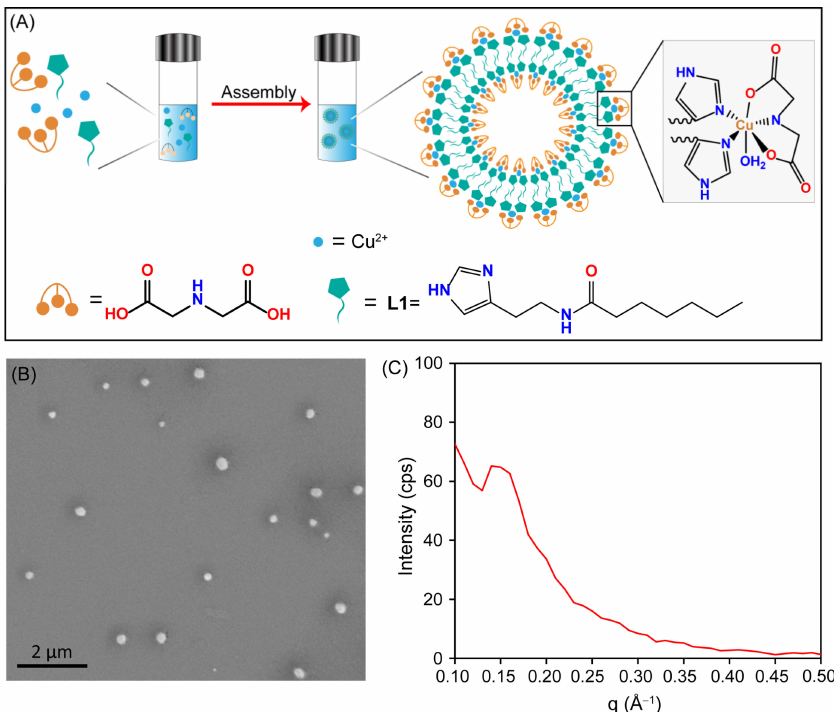
Figure 1. Fabrication of SupraZyme and its characterizations. ( A ) A schematic of assembly formation with Cu(NO 3 ) 2 , IDA, and ligand L1 . ( B ) SEM image of the SupraZyme showing vesicular structures, ( C ) SAXS spectrum of the SupraZyme showing a peak corresponding to the q value of 0.15 Å − 1 . Experimental conditions: [Cu 2+ ] = 100 µ M, [ L1 ] = 200 µ M, and [IDA] = 100 µ